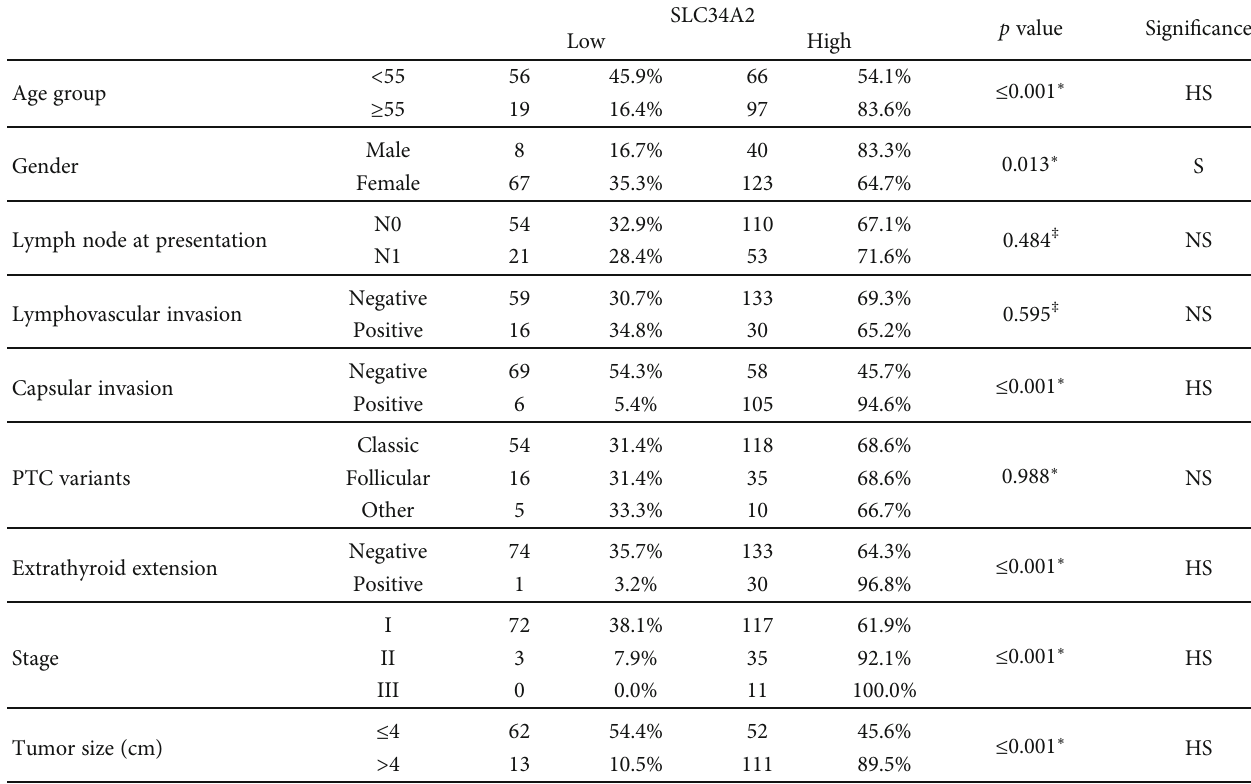
Table 2: Relationship between SLC34A2 IHC expression and clinicopathological characteristics.